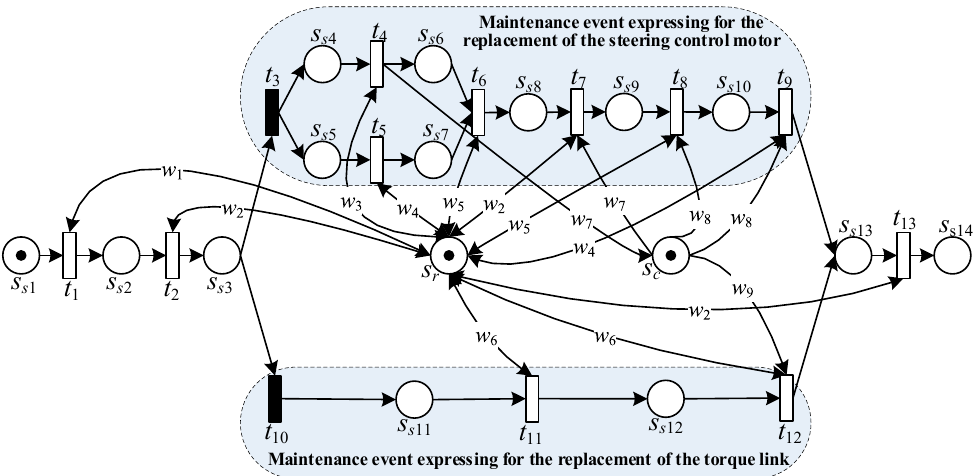
Figure 7. Maintenance process of the wheel steering system.